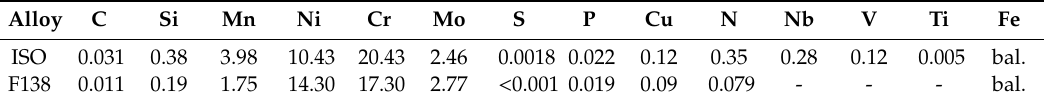
Table 1. Chemical composition of the two austenitic stainless steels